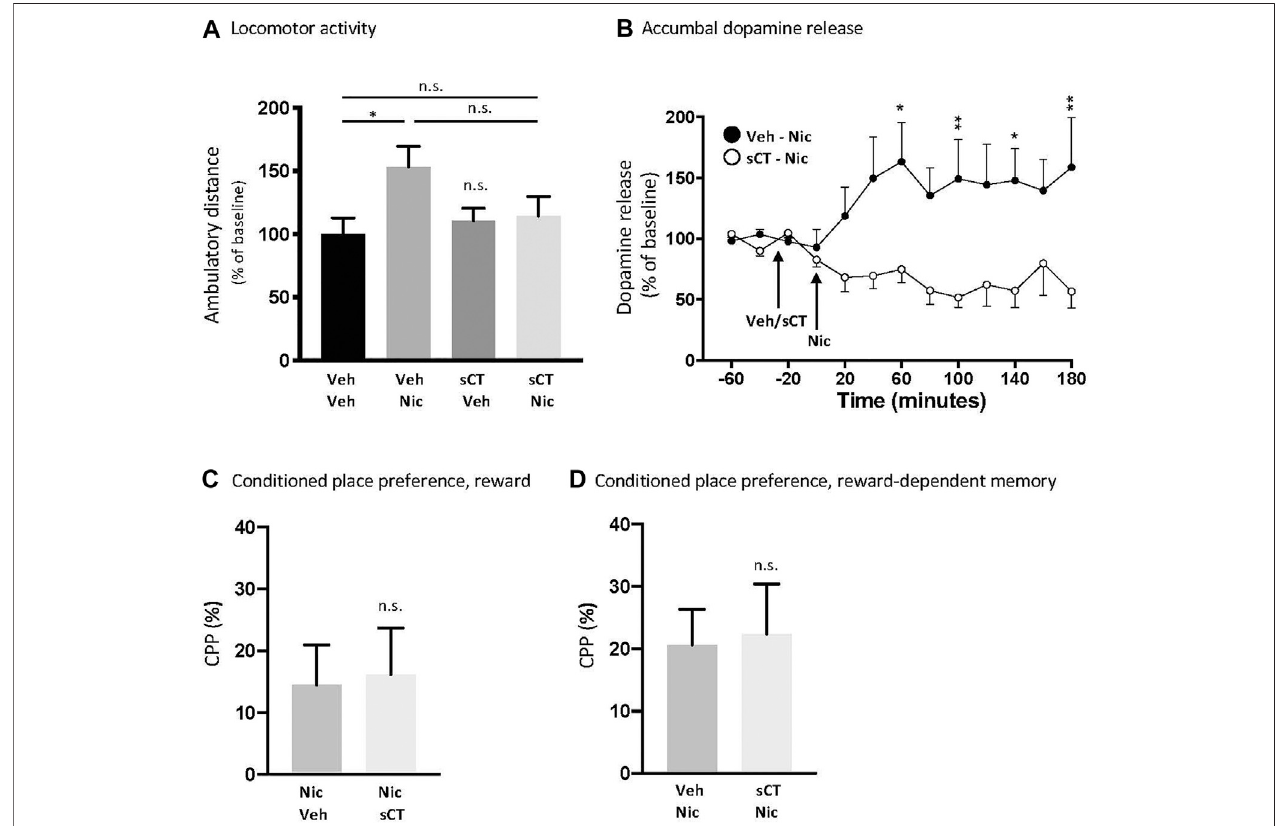
FIGURE 1 | Effects of acute systemic sCT administration on nicotine-induced behaviours in male mice (A) Nicotine (Nic, 0.5 mg/kg, IP) caused locomotor stimulation in mice pre-treated with vehicle (Veh), but not in mice pre-treated with sCT (5 μ g/kg, IP) (* p < 0.05 and n. s. not signi fi cant) (B) Dopamine release in the NAc shell induced by nicotine (0.5 mg/kg, IP) was higher in mice pre-treated with vehicle compared to those pre-treated with sCT (5 μ g/kg, IP) at the time points of 60, 100, 140, and 180 min (* p < 0.05, ** p < 0.01) (C) Nicotine-induced (0.5 mg/kg, IP) reward and (D) nicotine reward-dependent memory retrieval in the CPP paradigm was not affected by sCT (5 μ g/kg, IP) compared to vehicle (Veh) (n. s. not signi fi cant). Data are presented as mean ± SEM.